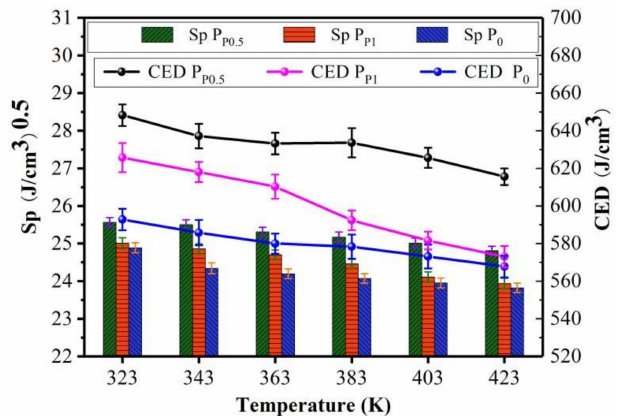
Figure 10. Solubility parameters (Sp) and cohesive energy densities (CED) of the three models at different